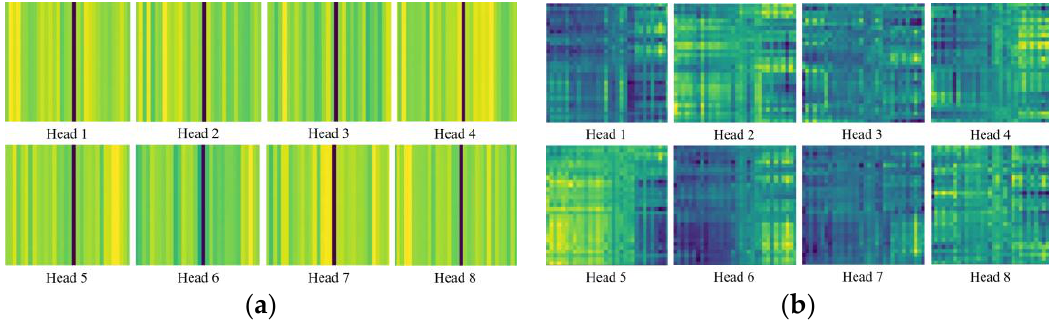
Figure 4. The input and output attention before optimization.